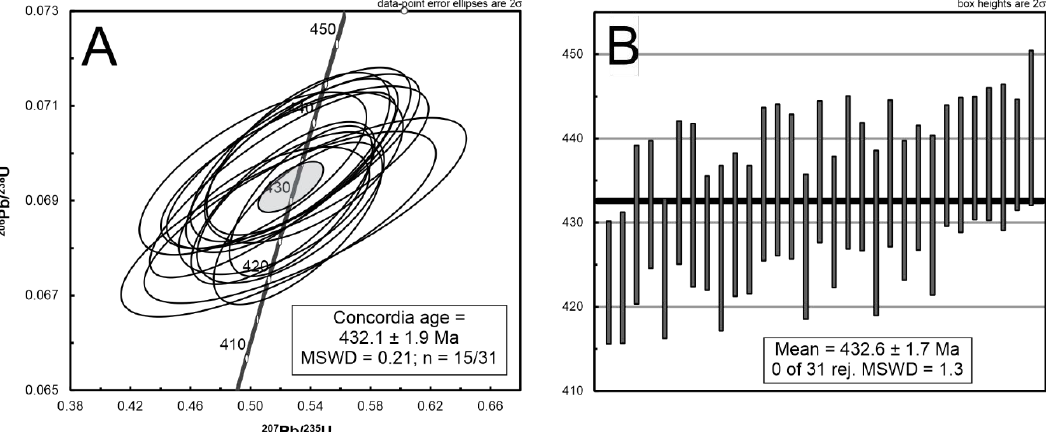
Figure 10. ( A ) U-Pb concordia diagram for titanite from a single thin section of Howard Peak Granodiorite-diorite. Age was determined from 15 points (Table 2; sample from drill core SB0806 at 63.7 m). ( B ) Plot of weighted mean of 206 Pb/ 238 U ages for the titanite grains analyzed.